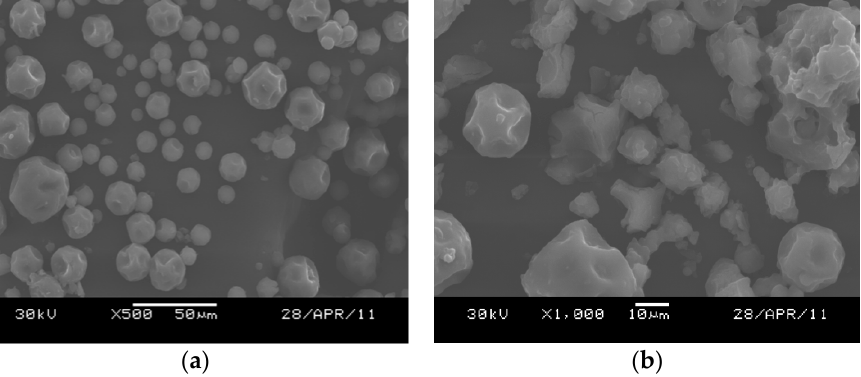
Figure 6. Morphology of the catalyst: ( a ) mixing TiCl 4 /toluene with Mg complex in 60 min; ( b ) mixing TiCl 4 /toluene with Mg complex in 2 min.